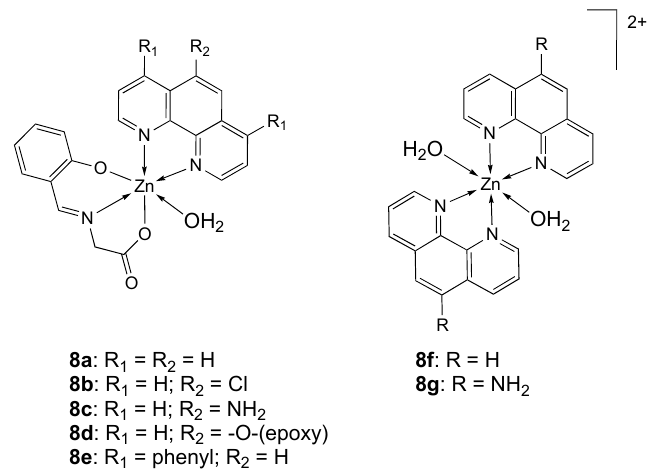
Figure 4. Structure of the zinc complexes 6 and 7 . Mixed-ligand zinc complexes with N -salicylideneglycinate (Sal-Gly) [86,93,112] and 1,10-